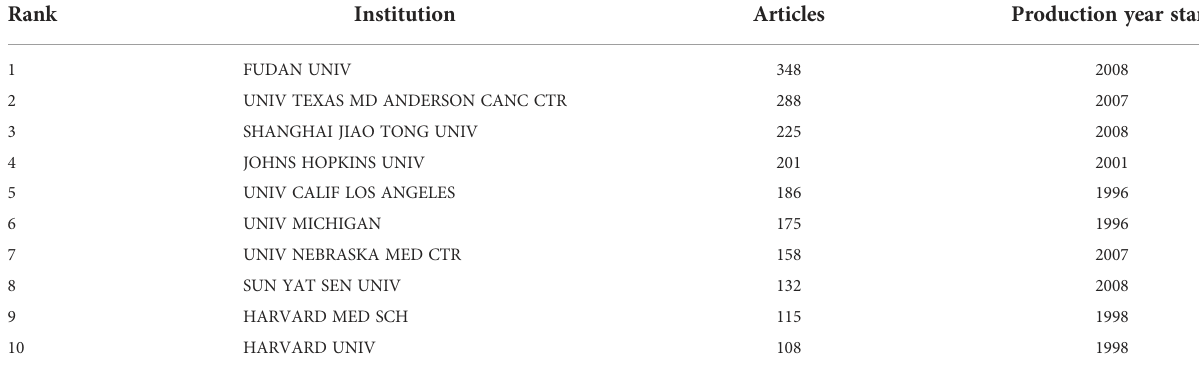
TABLE 3 Top 10 most productive institutions in the fi eld of pancreatic cancer metabolism.